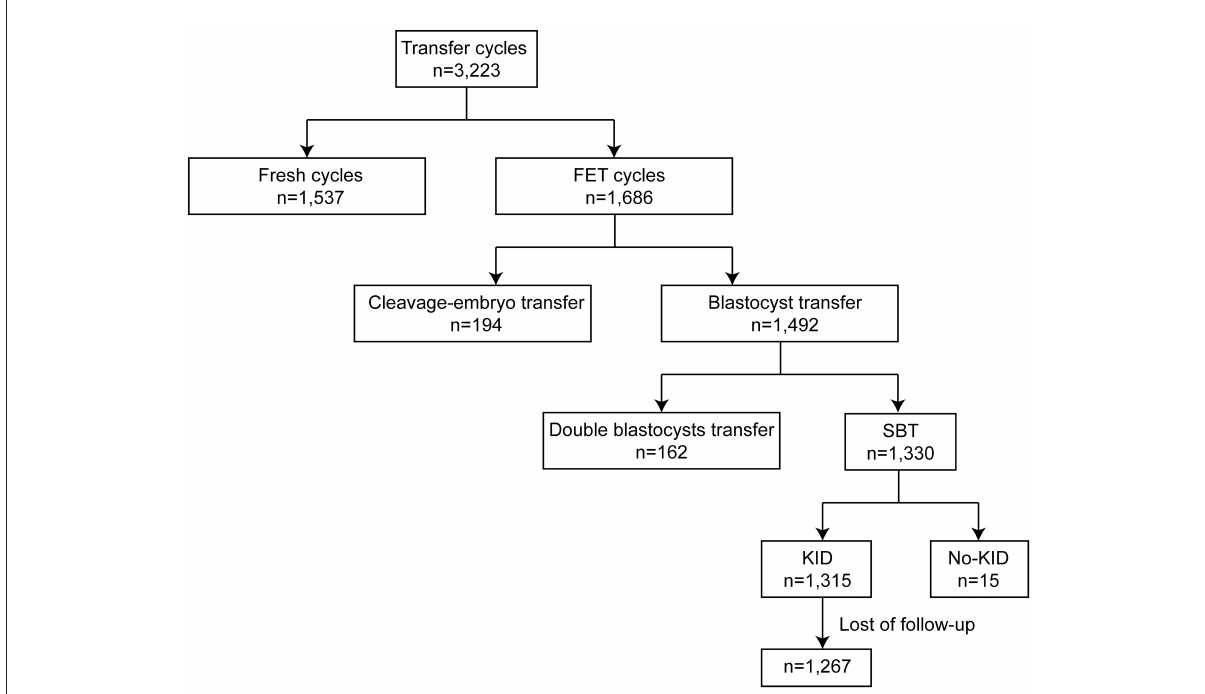
FIGURE1 Schematic presentation of the study design. SBT, single blastocyst transfer; KID, known implantation data. FET, frozen embryo transfer[[Inline